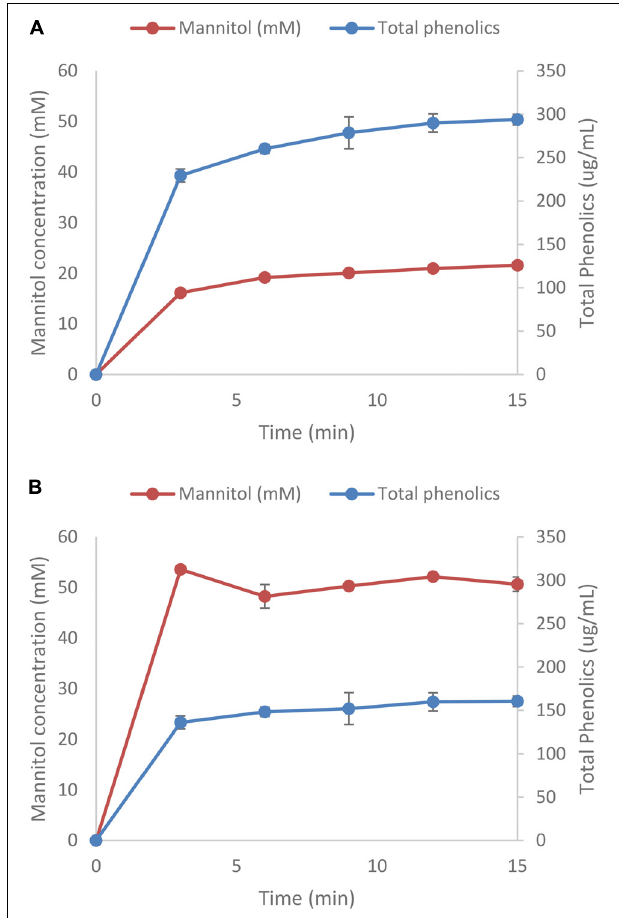
FIGURE 3 | Extraction of mannitol from Ascophyllum nodosum (A) and Laminaria digitata (B) . Protein was less then 0.2 mg/mL (data not shown).